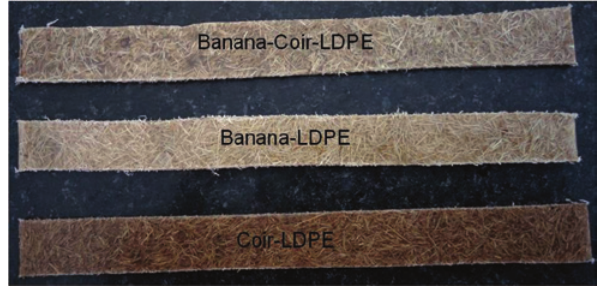
Figure 1: Tensile test specimens.